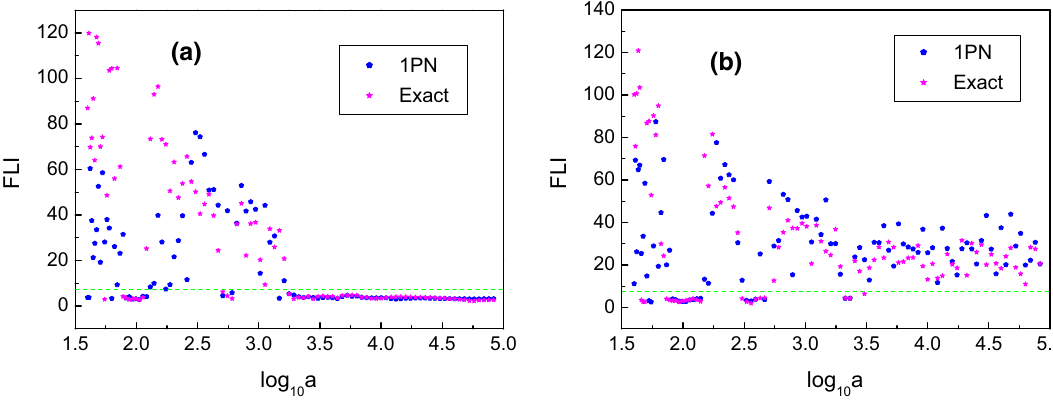
Fig. 14 Dependence of FLIs of Orbit 1 and Orbit 3 on a respectively in the exact system (12) and the 1PN truncated system